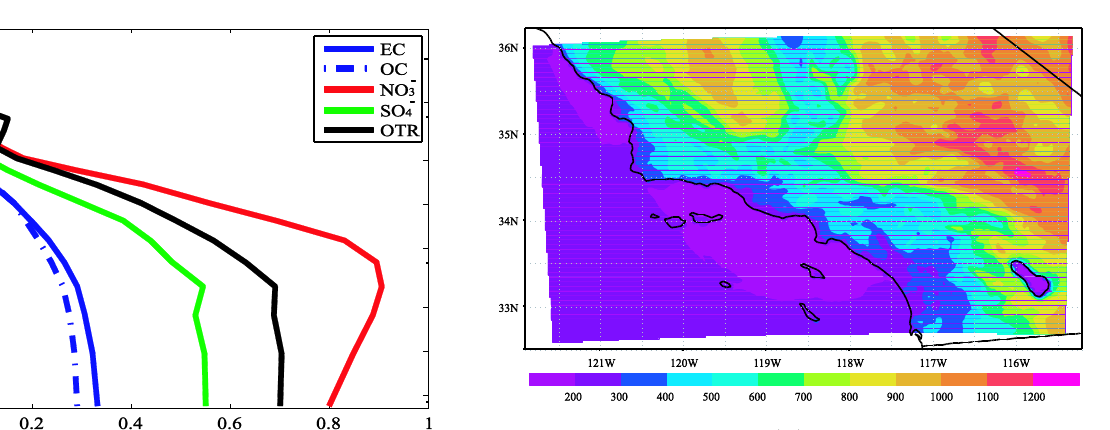
Fig. 3. Boundary layer heights (m) at 11:00UTC, 18 October 2011 Figure 3. Boundary layer heights (m) at 11 UTC, 18 October, 2011 generated by 3 generated by WRF/Chem, initialised at 00:00UTC, 16 October 2011 with the North America Regional Reanalysis WRF/Chem, initialized at 00 UTC, 16 October, 2011 with the North America Regional 4 Reanalysis (NARR). 5